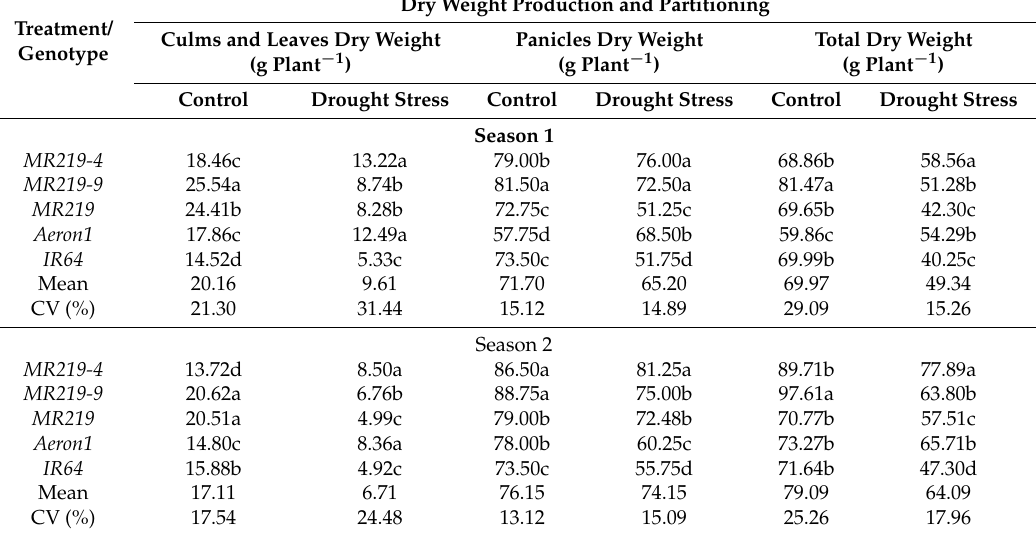
Table 4. Dry weight production and partitioning in rice genotypes as affected by drought stress treatment at different seasons.